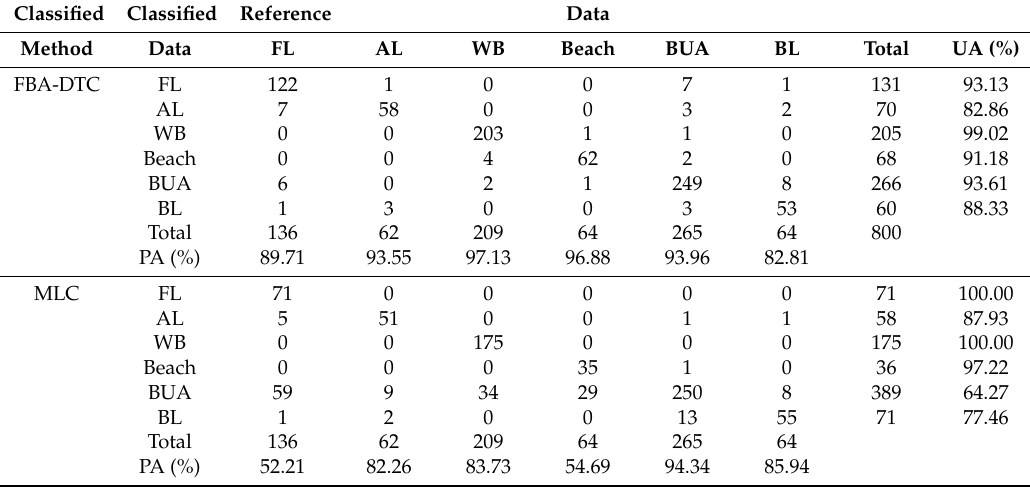
Table 3. Accuracy assessment of feature-based approach of decision tree classification (FBA-DTC) and maximum likelihood classification for the 2015 image.